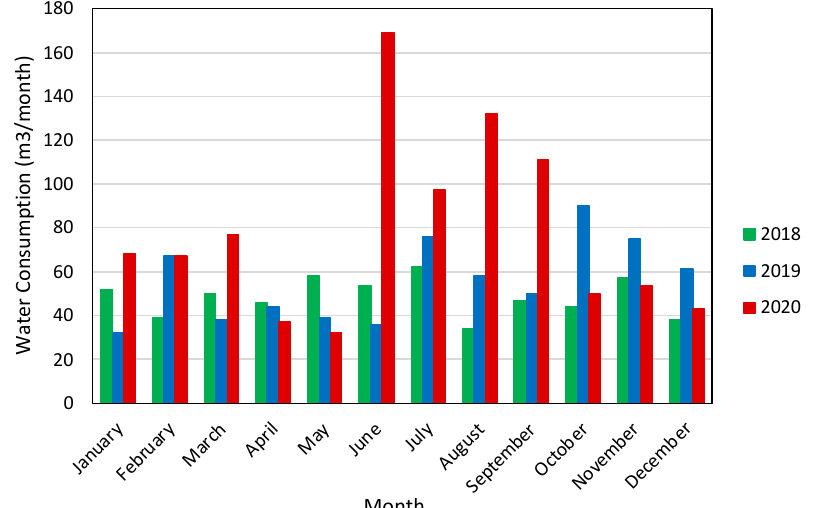
Figure 9. Monthly water consumption per connection (2018–2020).